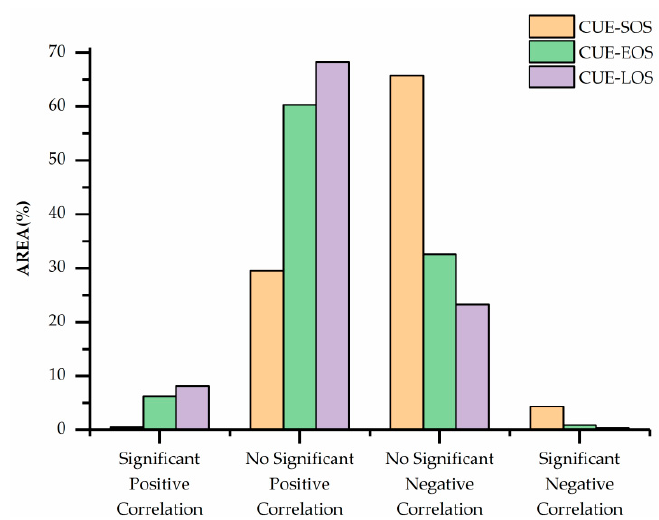
Figure 11. The area percentages of correlation coe ffi cients between CUE, SOS, EOS and LOS. (Significant